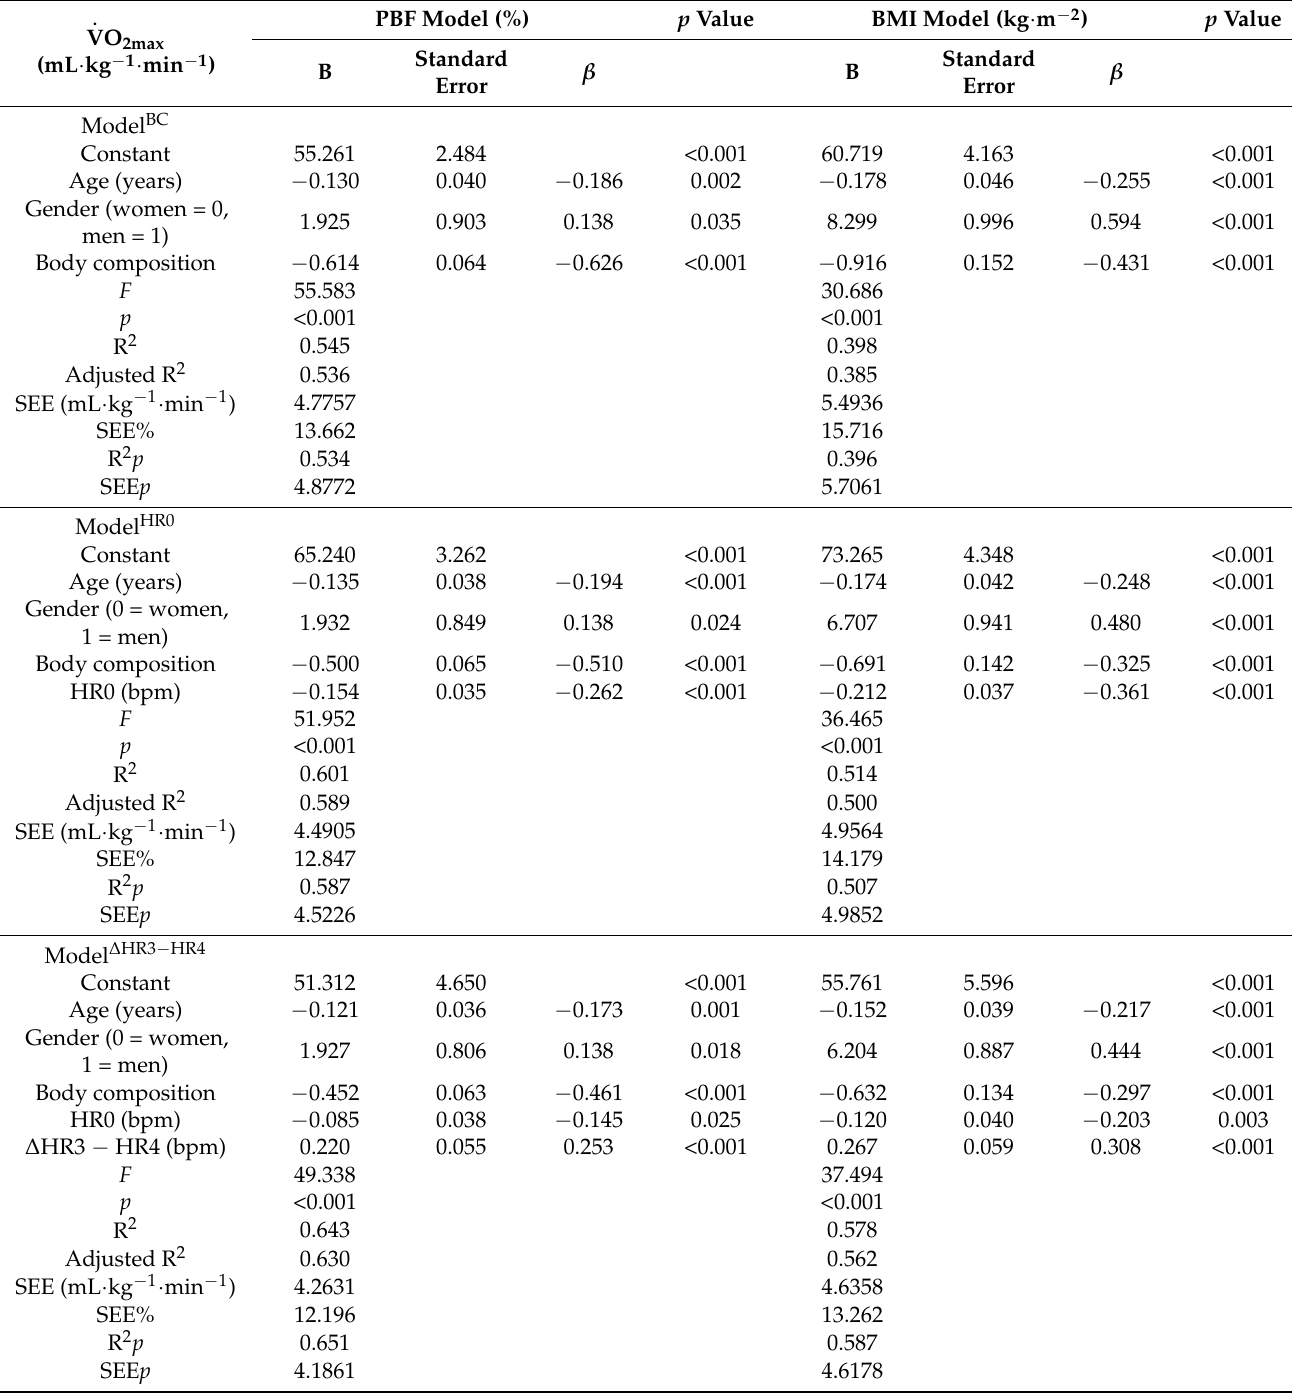
. VO 2max (mL · kg − 1 · min − 1 ).